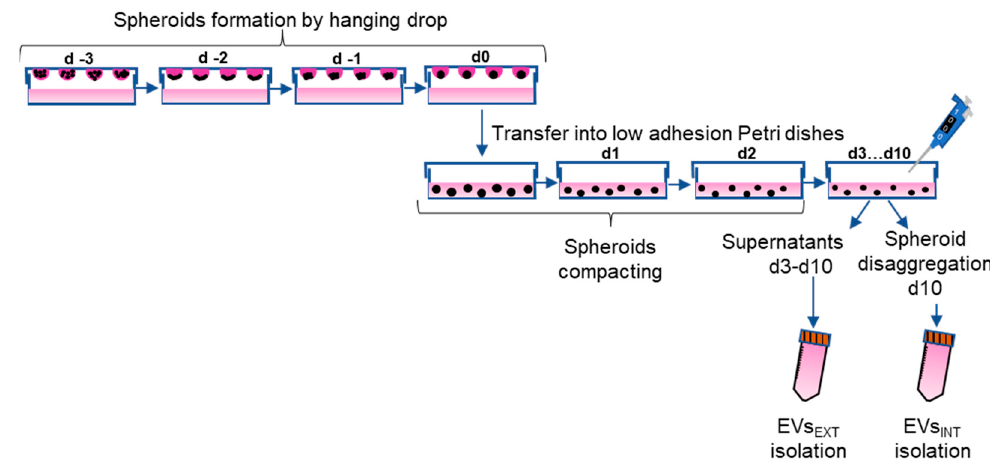
Figure 1. Experimental scheme. Spheroids were formed by “hanging drop” from day − 3 to day 0 (d − 3–d0) then transferred into low adhesion Petri dishes on d0. Spheroids were left to compact for 72 h (d0–d3) and from d3 to d10 EVs EXT were collected. On d10, spheroids were disaggregated as described in Methods and EVs INT were isolated. “Day 0” was chosen to signify the day spheroids were moved from drop to Petri; from day zero (d0) the previous 3 days (as d − 1, d − 2, d − 3) and the following 10 (d1–d10) were